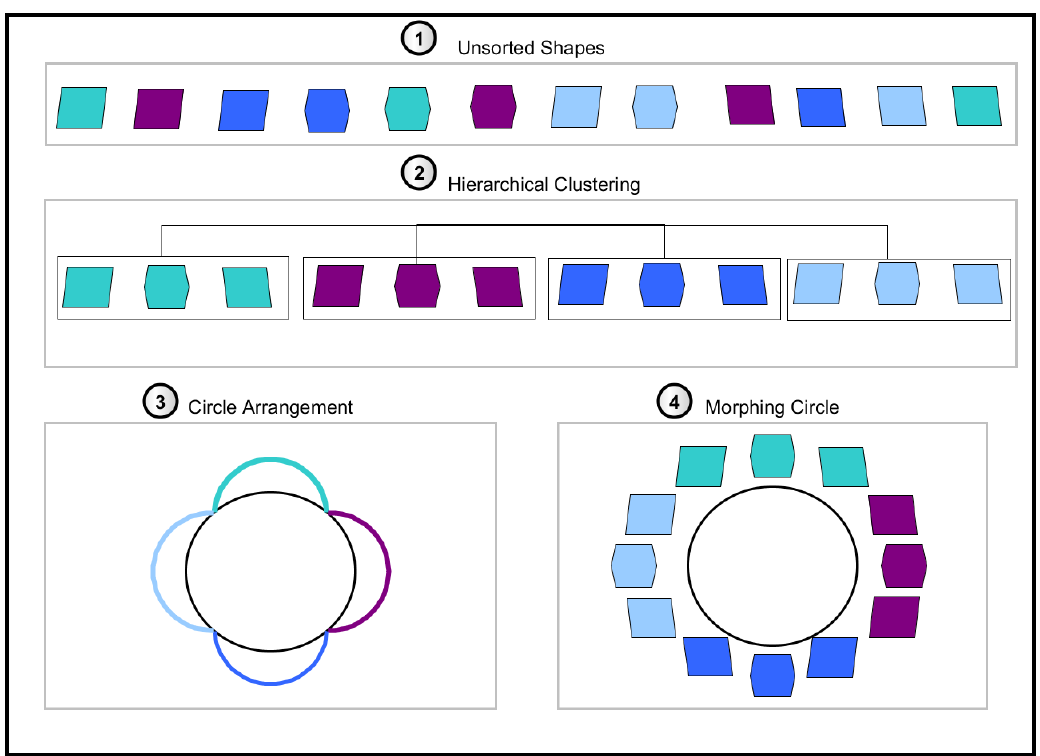
Figure 9. Overview of shape analysis and creation of bending patterns: colours of single elements represent different classes, and shapes of elements represent varying properties of bending